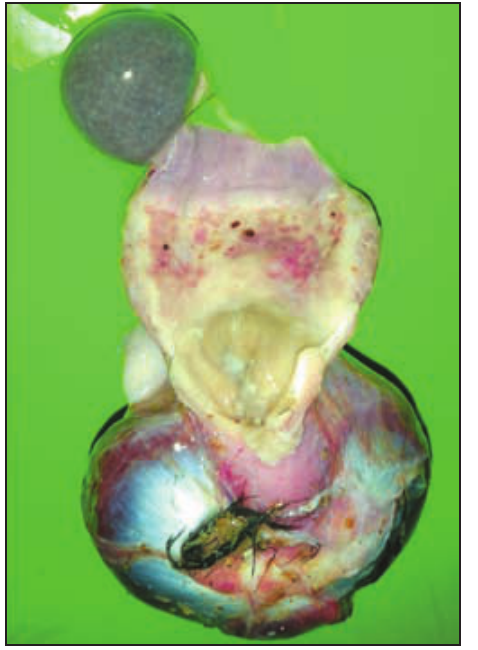
Fig. 1. Pinpoint haemorrhages in the summit of papillae of